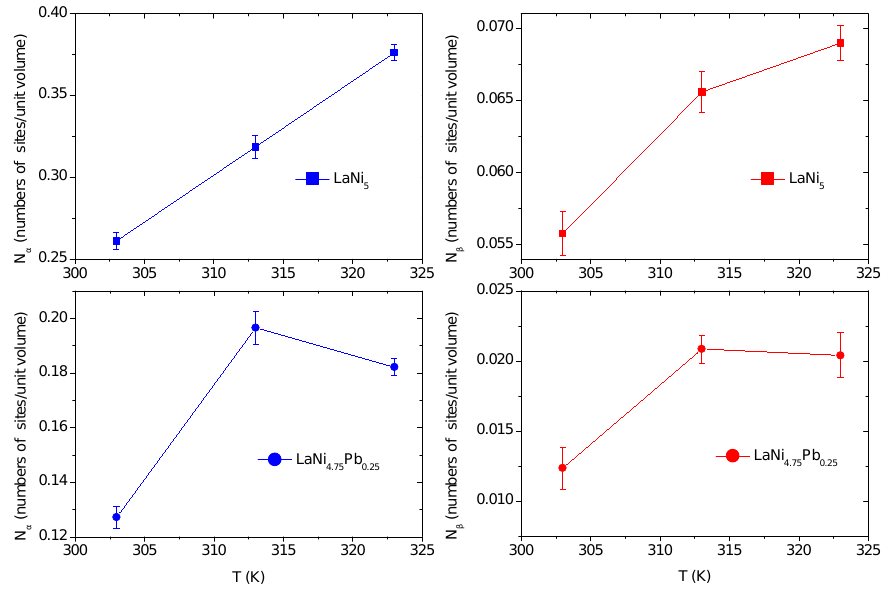
Figure 5. The temperature evolution of the number of the still available receptor sites N α , N β